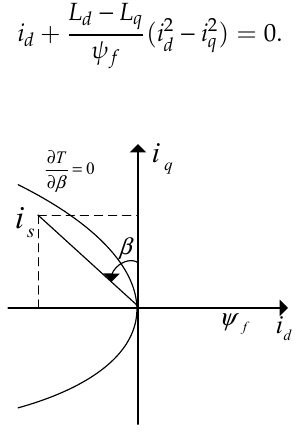
Figure 3. Space vector analysis of the PMSM.